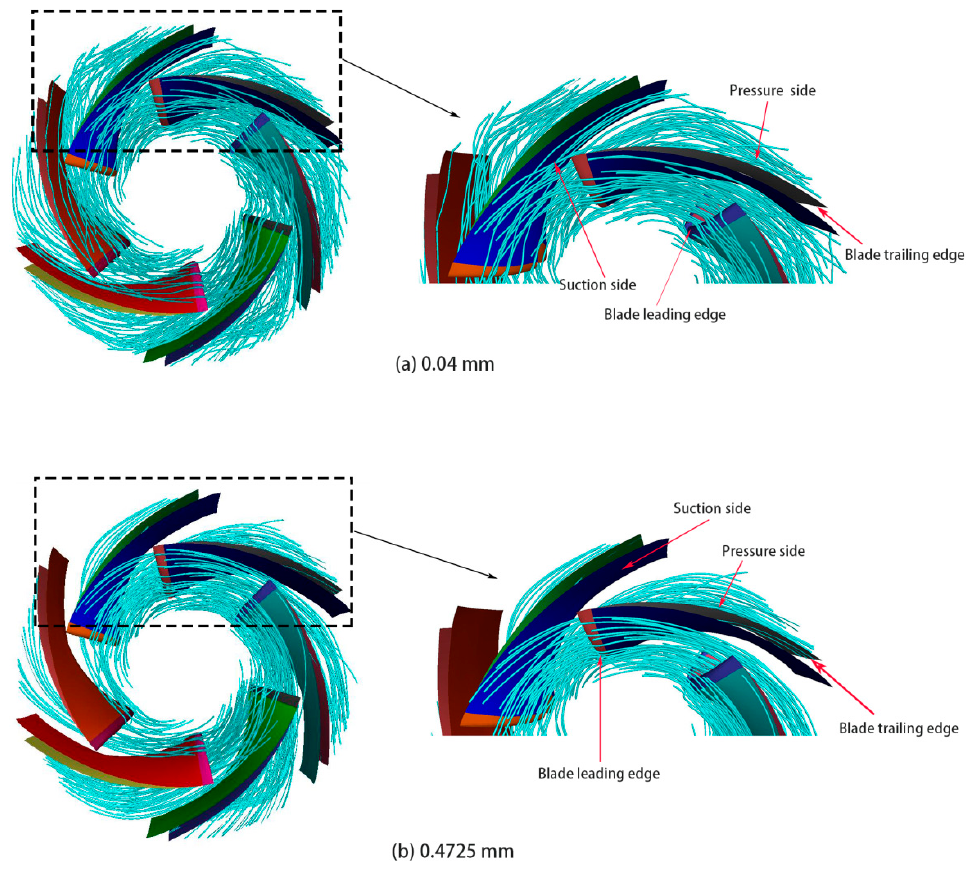
Figure 12. Particle trajectory.